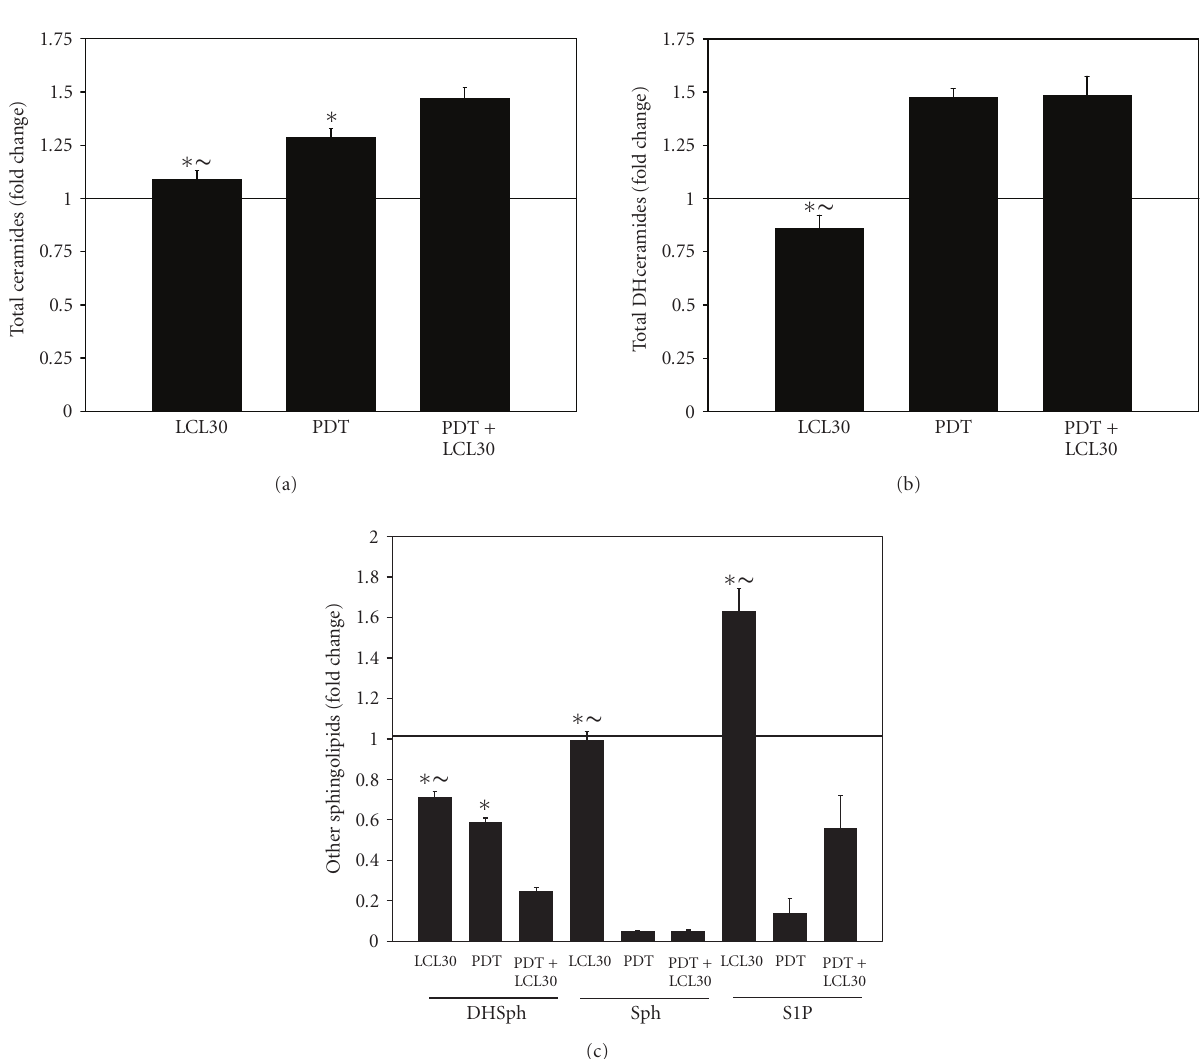
Figure 3: The e ff ects of treatments on the SL profile. (a)–(c) Total ceramides, DHceramides, and other SLs, respectively. The data are expressed as fold changes, that is, ratios of treated versus controls (Pc 4 alone and untreated controls) and are shown as average ± SEM from four independent determinations. For other details, refer to Figure 2 legend. The significance ( P < . 05) is shown as follows: ∗ indicates the significant di ff erence between an individual treatment, LCL30 or PDT, and the combination (PDT+LCL30); ∼ indicates the significant di ff erence between LCL30 and PDT. DHSph, dihydrosphingosine; Sph, sphingosine.